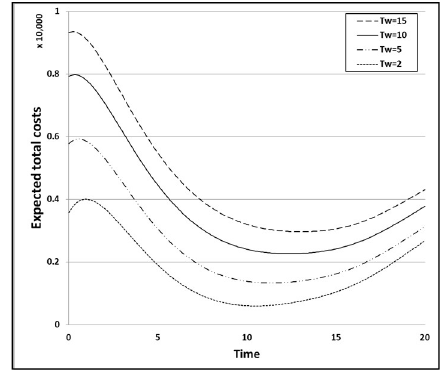
Figure 13. Expected total cost subject to the warranty period for the 2 nd condition.